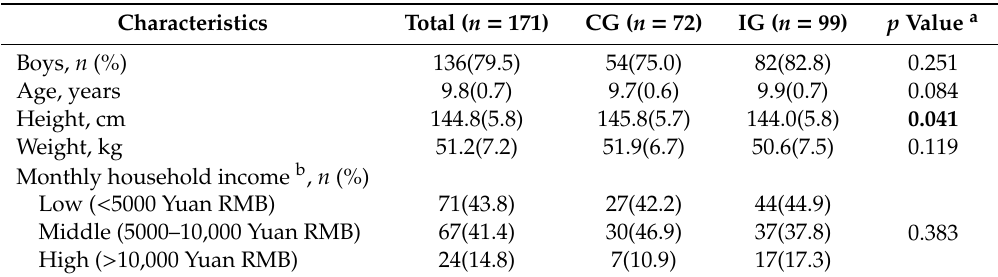
Table 2. Basic characteristics of participants at